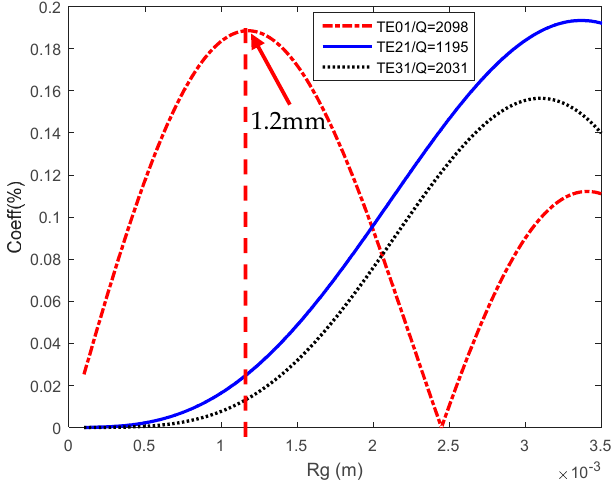
Figure 4. The coupling factor of different modes variation on beam radius.